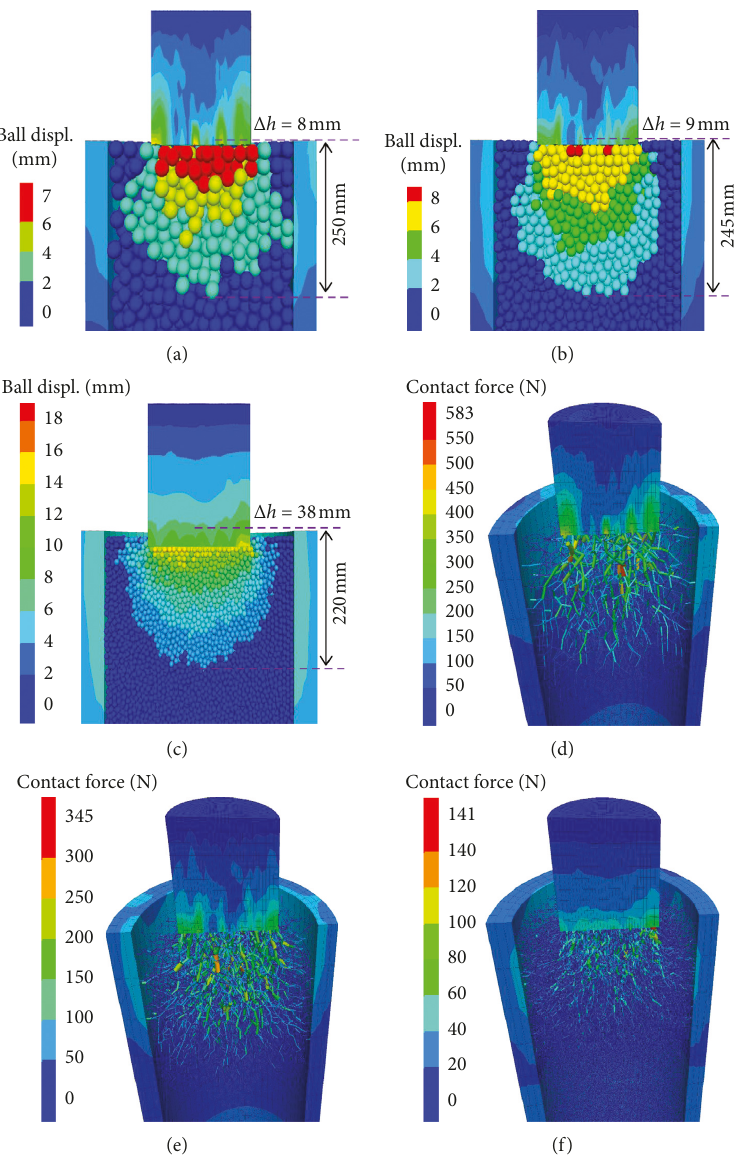
Figure 7: Particle displacement diagram with radius of (a) 15mm, (b) 10mm, and (c) 5mm; particle contact force chain diagram with radius of (d) 15 mm, (e) 10mm, and (f) 5 mm under the action of a flat-bottomed